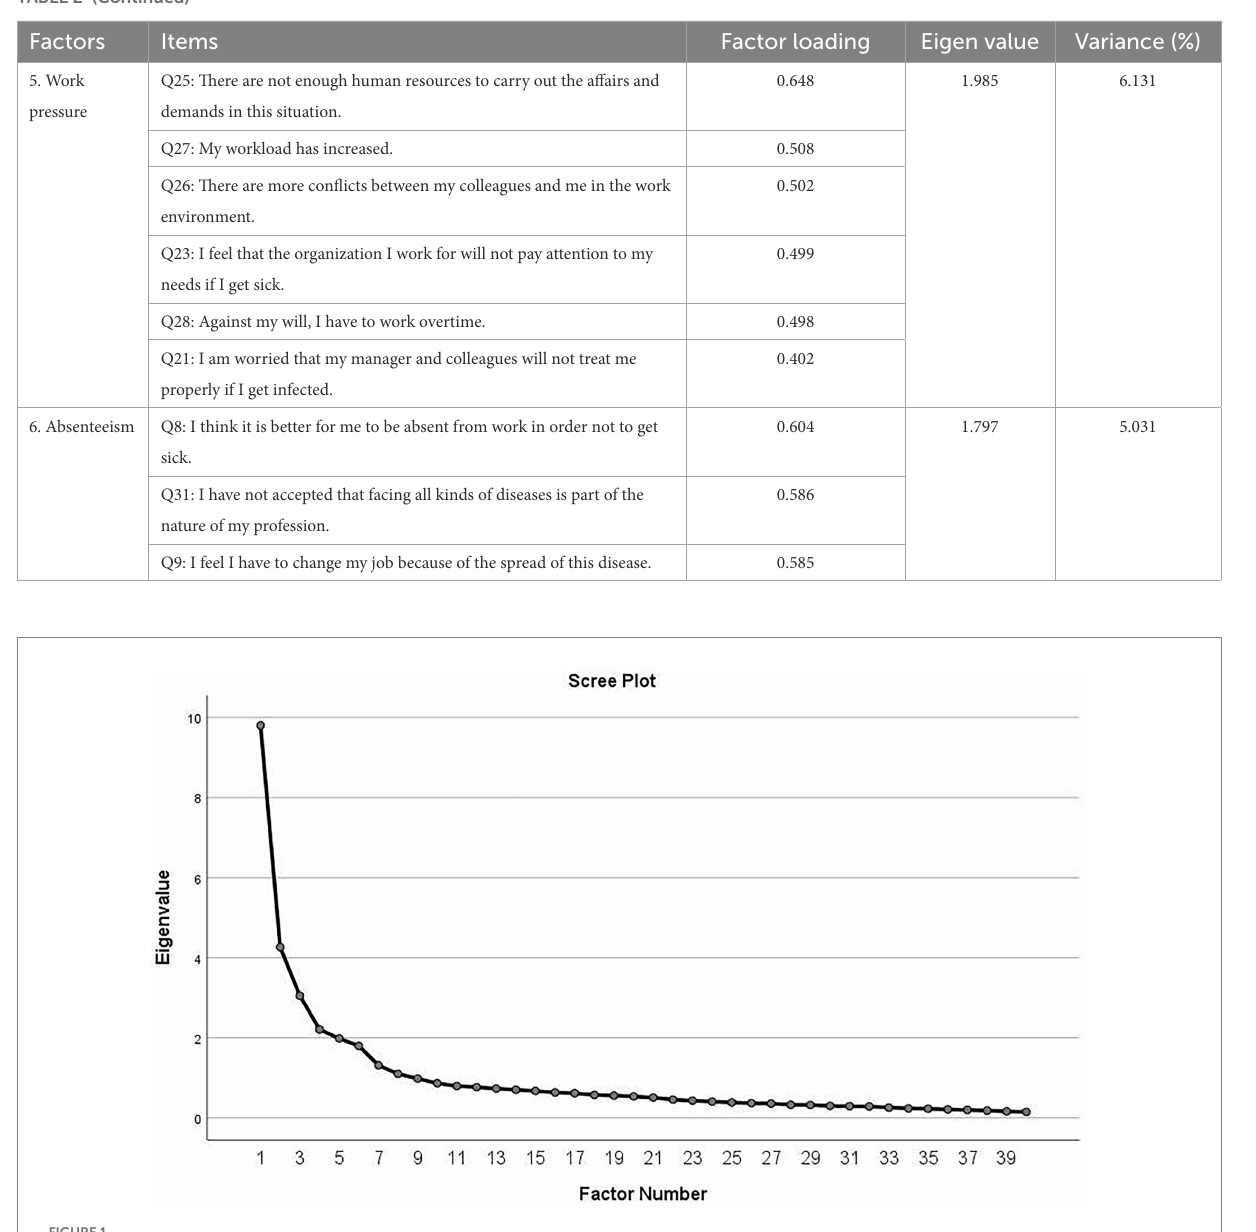
FIGURE 1 Scree plot. Based on the scree plot, six factors were proposed for extraction in the EFA of the